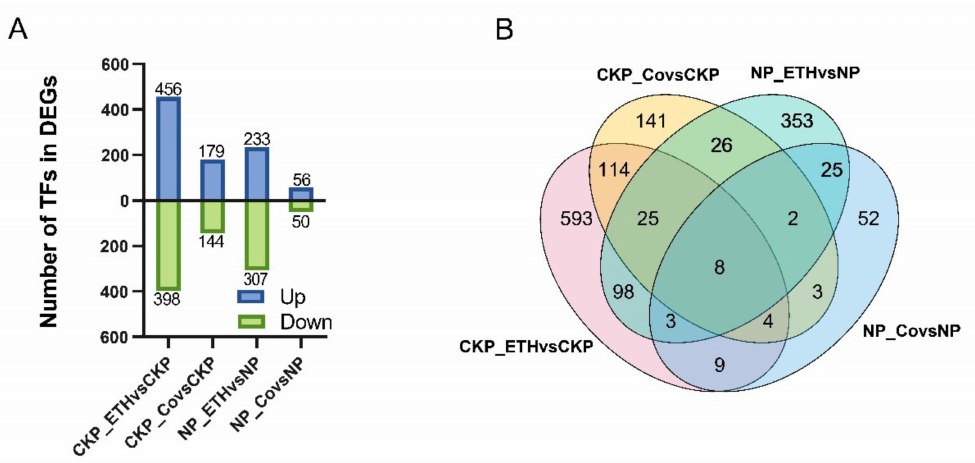
Figure 4. Identification of DEGs in four treatment groups, namely CKP (normal phosphate (Pi), NP (Pi starvation), CKP_ETH (normal Pi and ethephon), CKP_Co (normal Pi and CoCl 2 ), NP_ETH (Pi starvation and ethephon), NP_Co (Pi starvation and CoCl 2 ). ( A ) The histogram indicates upregulated and downregulated DEGs, blue indicates up-regulation, green indicates down-regulation, Y -axis indicates the number of DEGs, and X -axis represents the experimental group name. ( B ) Venn diagram of the DEGs among four treatment groups, and the number represents the number of